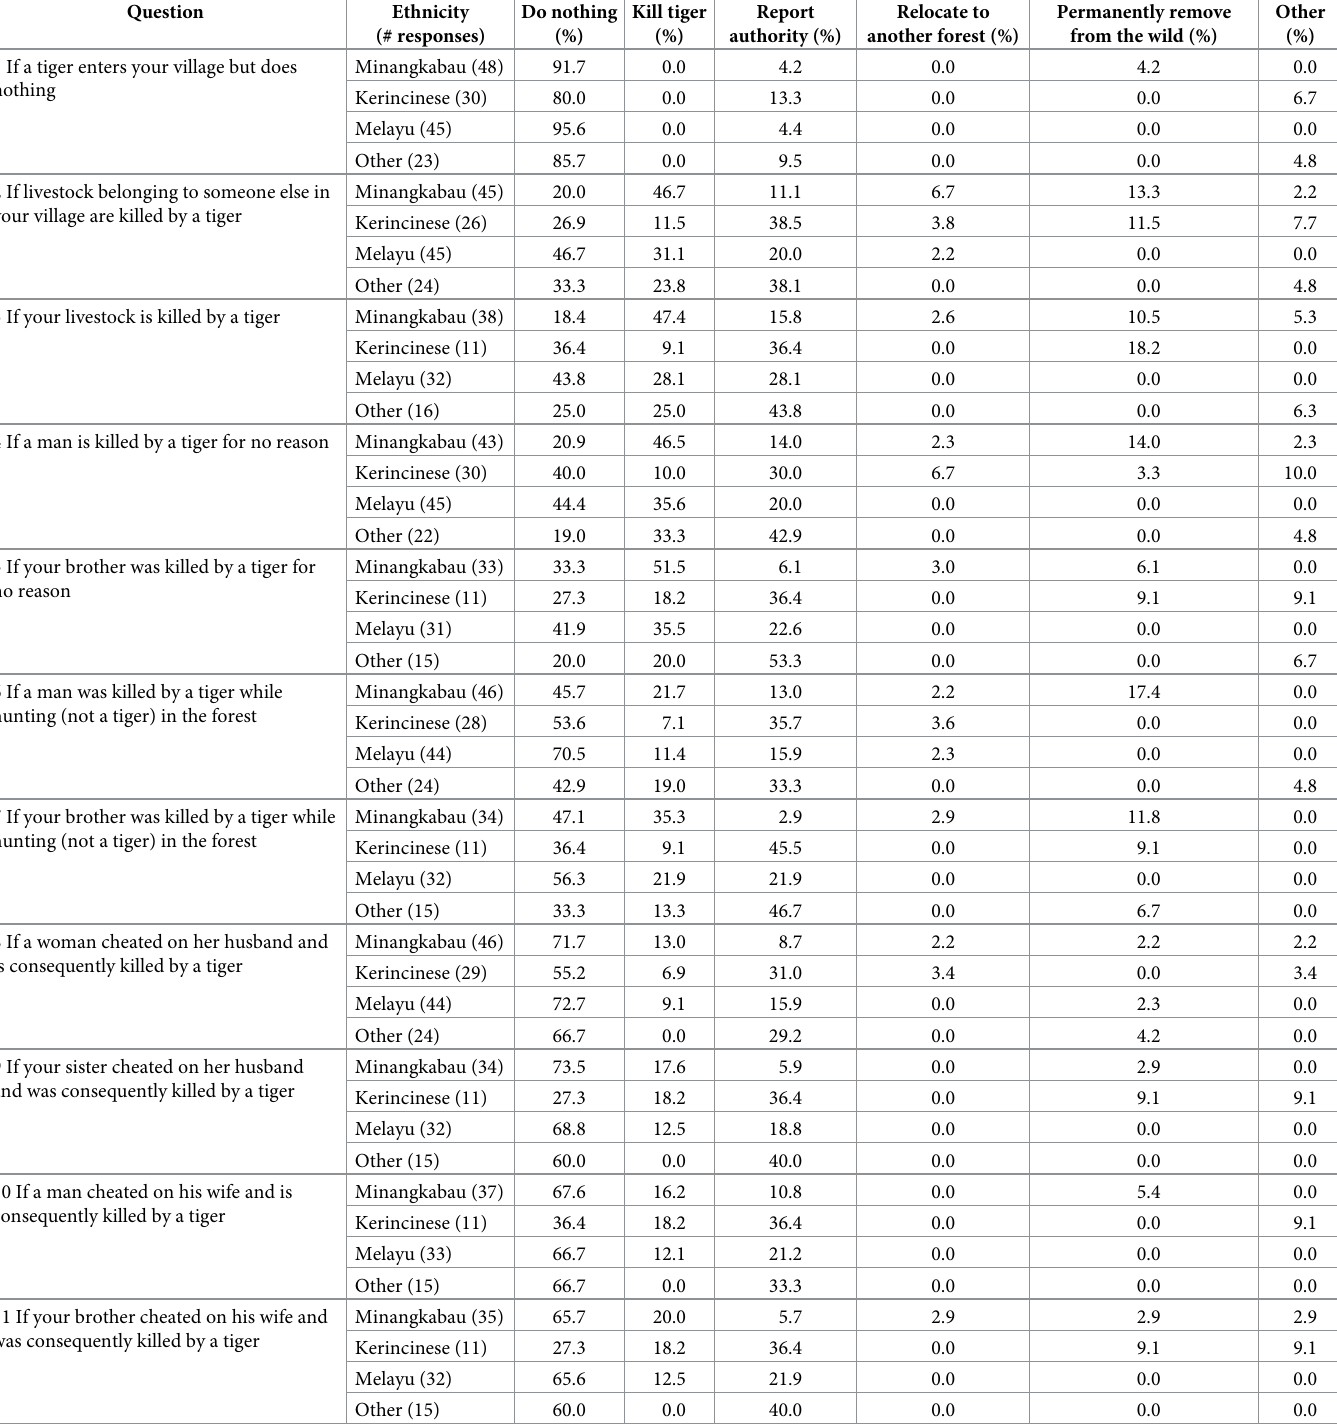
Table 4. Percentage of interviewees from each ethnic group giving difference responses to each of the human-tiger conflict scenarios.